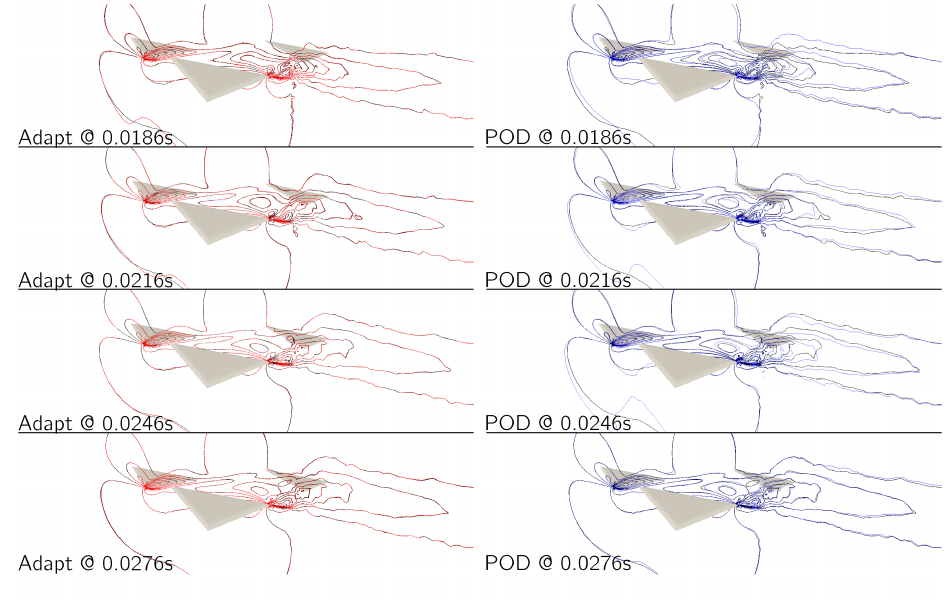
Figure 23. Comparison of the volume solution in terms of ρ for the formation flight test case. The black contours report the CFD reference solution; the coloured contour lines show the ROM reconstruction. The left column shows the adaptive reconstruction; the right column shows the pure POD reconstruction. Slice taken at 0.45 m from the plane of symmetry. Number of modes fixed, N m = 15.